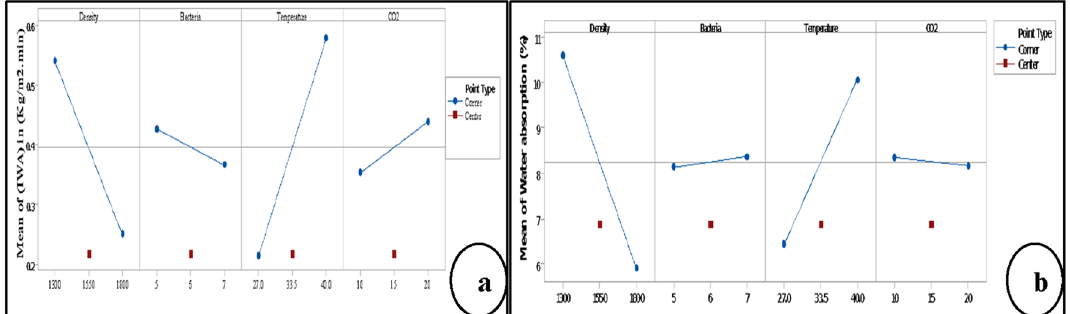
Figure 7. The main effects plots of the factors by factorial analysis ( a ) response is initial water absorption ( b ) response is water absorption.